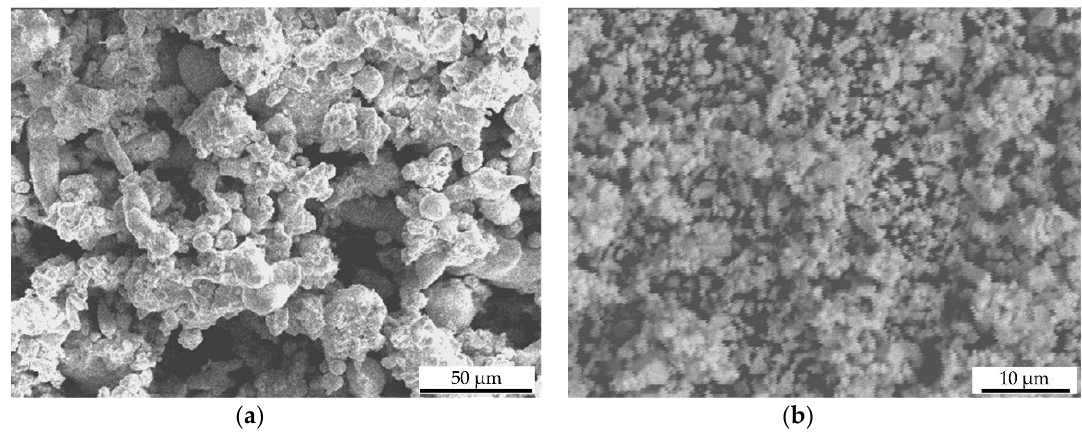
Figure 2. Scanning electron microscopy (SEM) images of the powders: ( a ) CuZn40; ( b ) WC.